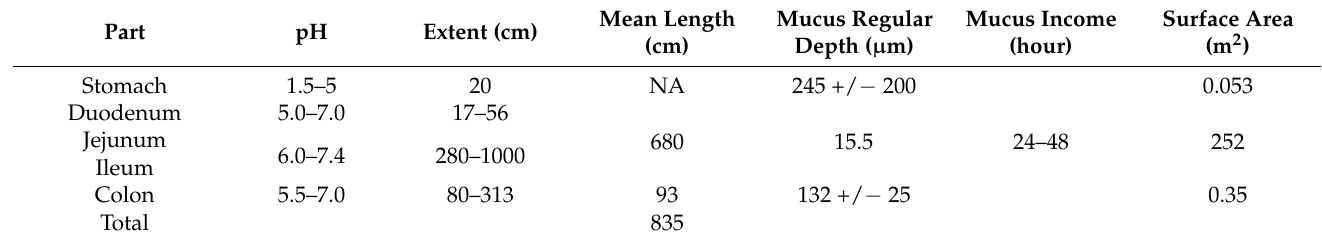
Table 4. Physicochemical attributes of several sections of the GI